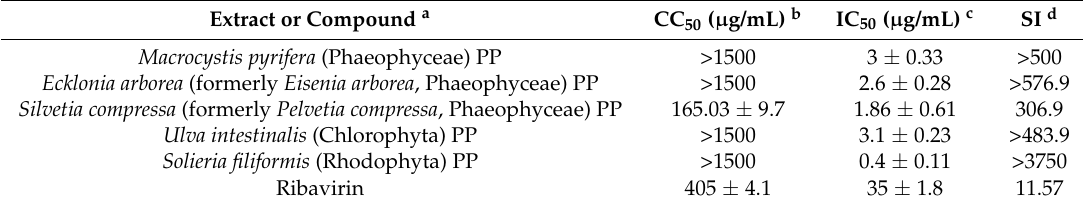
Table 1. Cytotoxic effect, antiviral activity and selectivity index of PPs.